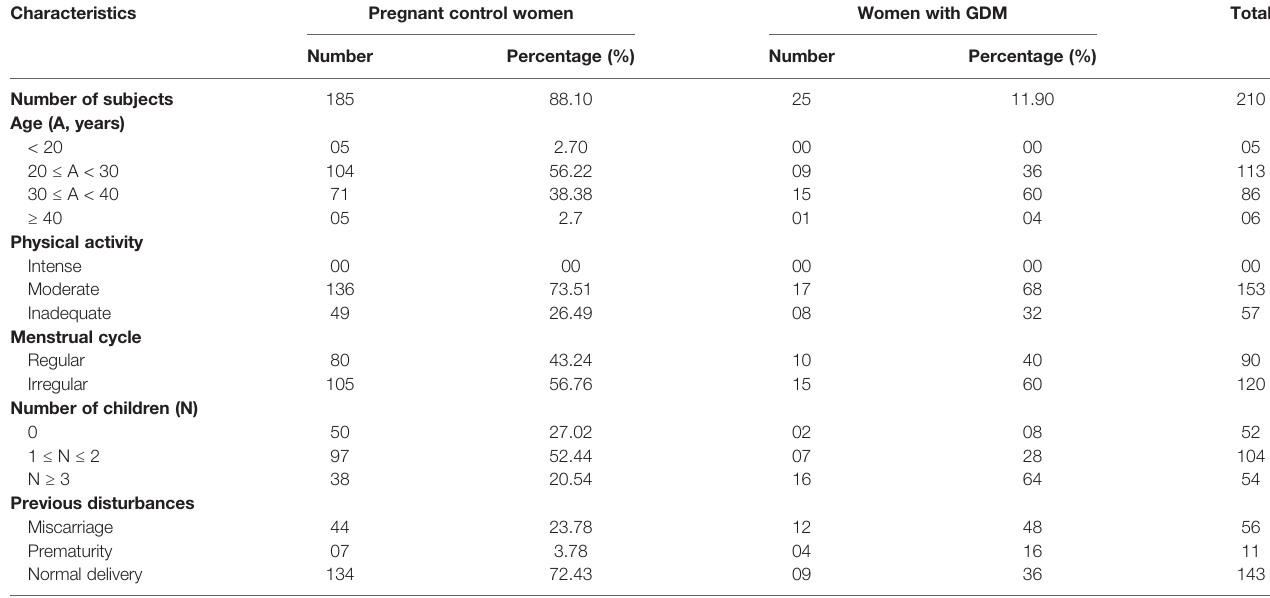
TABLE 1 | Anthropometric data of